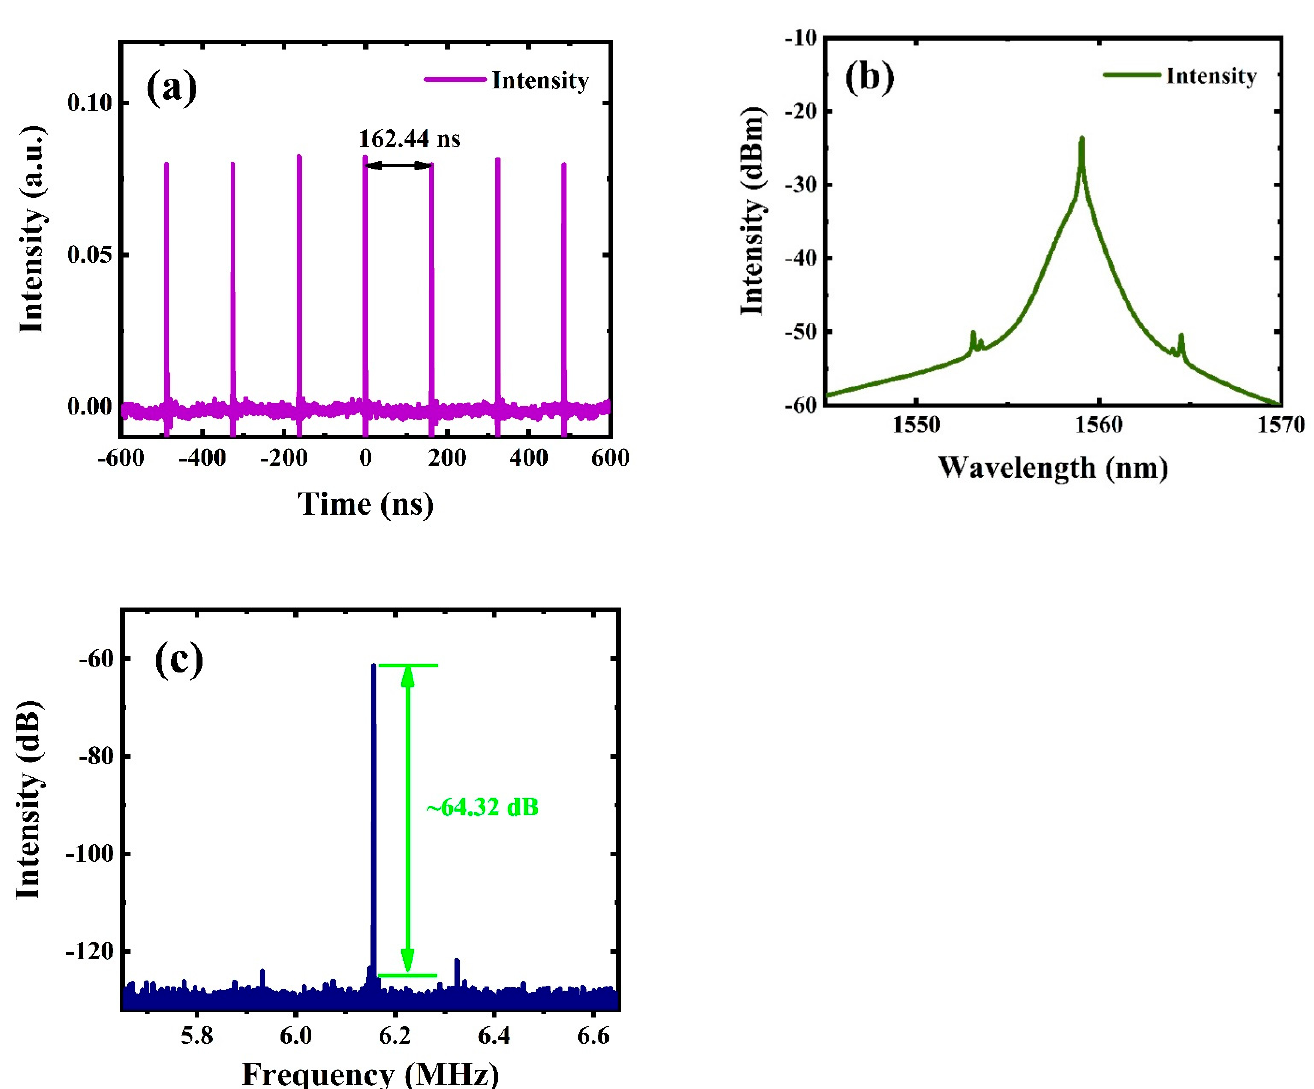
Figure 4. Characteristic diagram of output pulses at 30.4 mW. ( a ) Pulse sequences. ( b ) Optical spectrum. ( c ) RF spectrum.